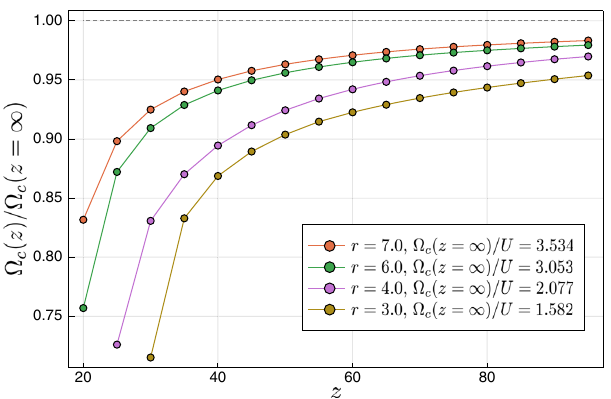
FIG. 15. Critical frequency for quantum synchronization, Ω within DMFT NCA, as a function of the lattice connectivity z , for different values of the drive-to-loss ratio r and hopping fixed on the phase boundary J=U ¼ ð J=U Þ to the mean-field value obtained for z ¼ ∞ . We see that decreasing z renormalizes down the frequency but does not destroy the limit cycle. Parameters: dim